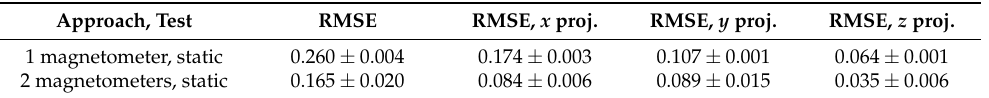
Table 1. Mean and standard deviation in mm of the root-mean-squared error (RMSE) and its projections on different axes with current and previous approaches. Approach, Test RMSE RMSE, x proj. RMSE, y proj. RMSE, z proj.